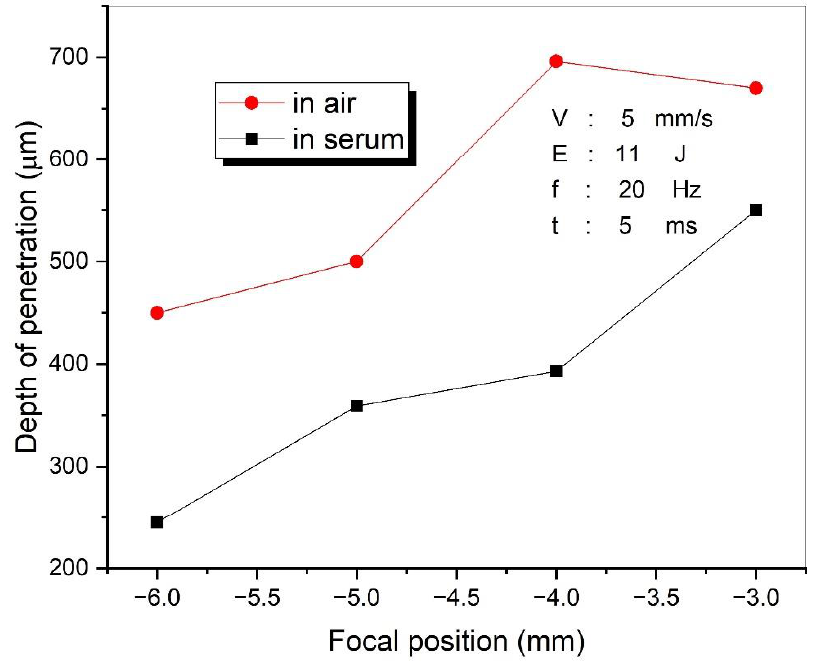
Figure 3. The variations in the penetration depth with the focal position.